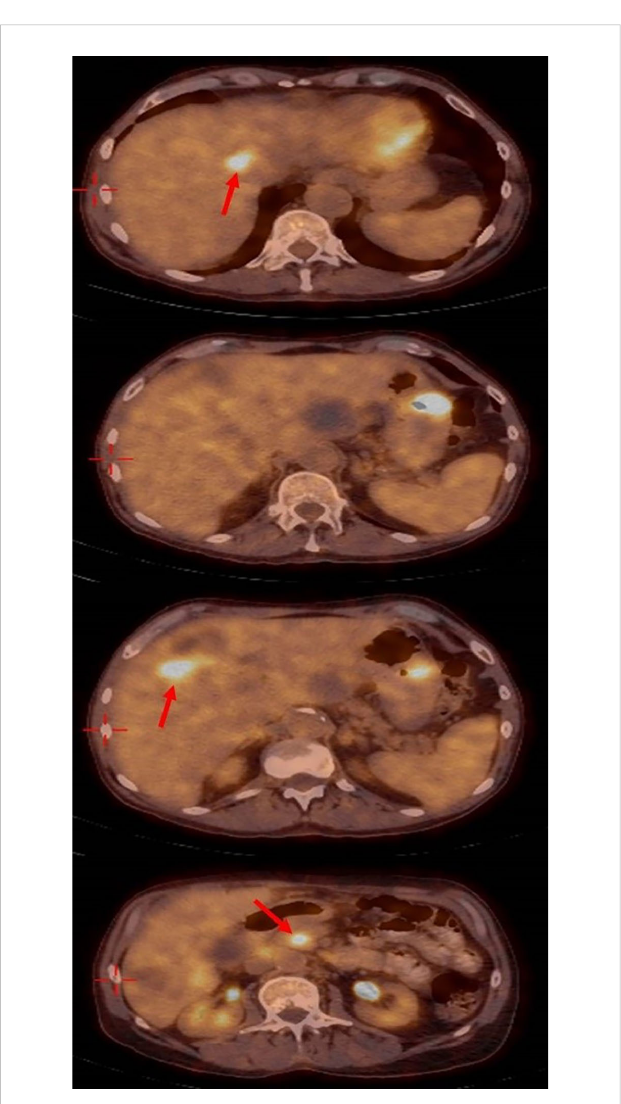
FIGURE 4 Positron emission tomography – computed tomography showing the signi fi cant response with disappearing of most liver